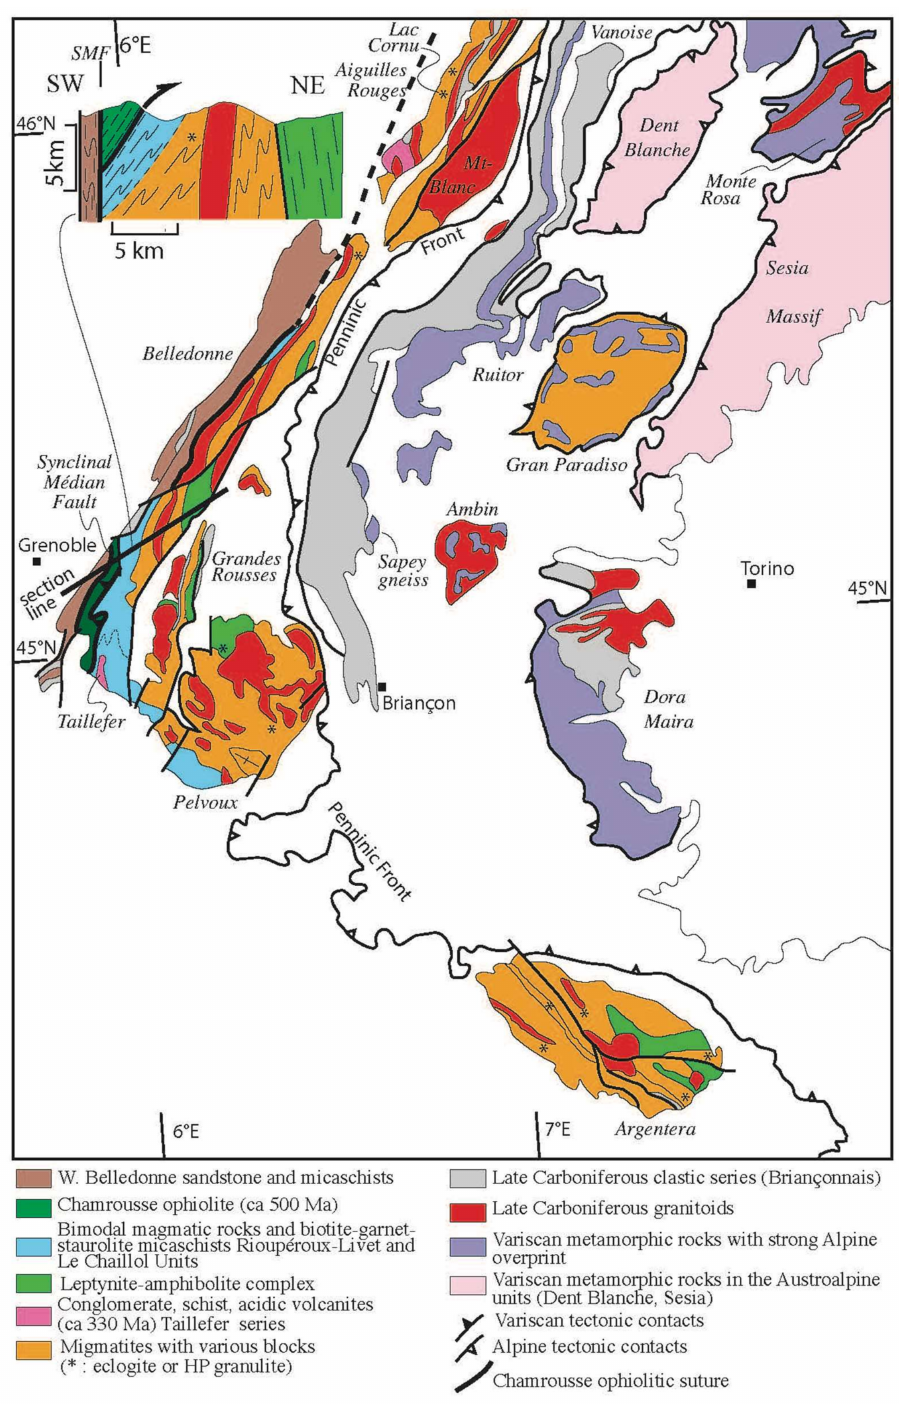
Figure 6. Structural map of the Variscan basement in the Western Alps: Helvetic Crystalline massifs (Argentera, Belledonne, Grands Rousse, Pelvoux, Mt-Blanc, Aiguilles Rouges, Aar Gothard); Bri- ançonnais substratum; Penninic crystalline massifs (Dora Maira, Ambin, Gran Paradiso, Monte Rosa). The cross section of the S. Belledonne massif is located in the map. From West to East, the Penninic front separates the External (or Helvetic) and Internal (or Penninic)